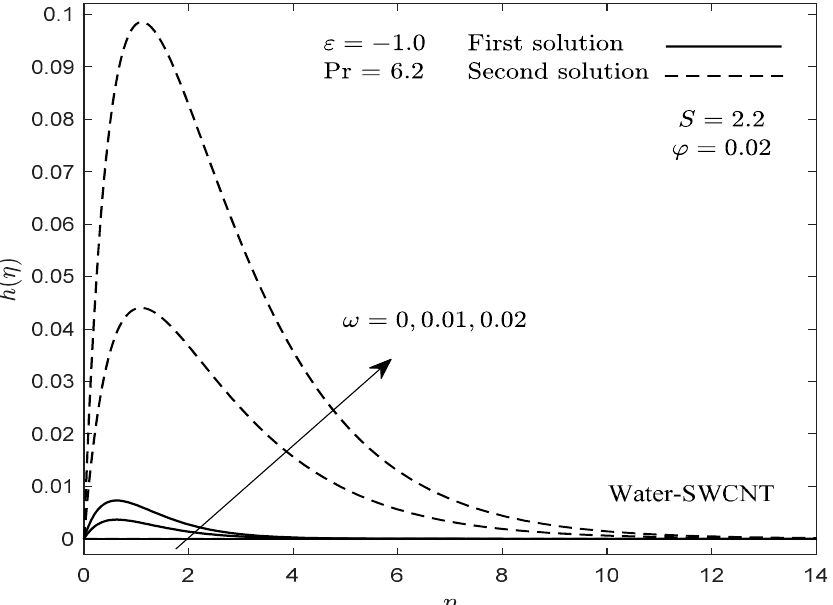
Figure 8. Velocity profiles of 𝑦 -component ℎ(𝜂) for some values of 𝜔 .